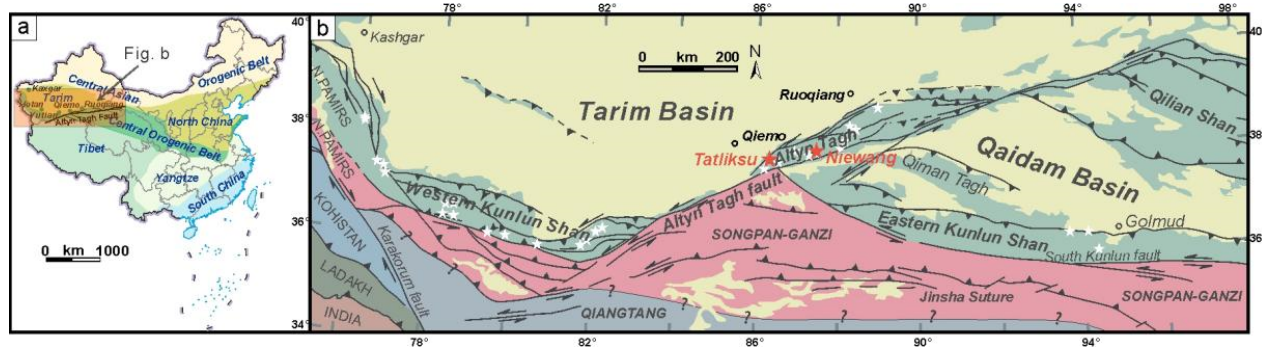
Figure 1. ( a ) Distribution of major tectonic units in China, modified after the outline map of China [censor code of GS(2019)1651] from the Ministry of Natural Resources of China; ( b ) Schematic geo- logical map of the northern Tibetan Plateau and the distribution of primary nephrite deposits in Altyn Tagh, Western Kunlun and Eastern Kunlun (stars in white and red). The Niewang and Tat- liksu nephrite deposits (stars in red) located in Altyn Tagh and near the Altyn Tagh Fault (ATF), modified after [3,24,25].